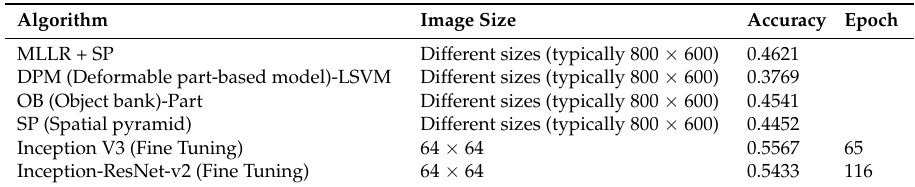
Table 13. Comparison table of some methods using the dataset of architectural styles (25